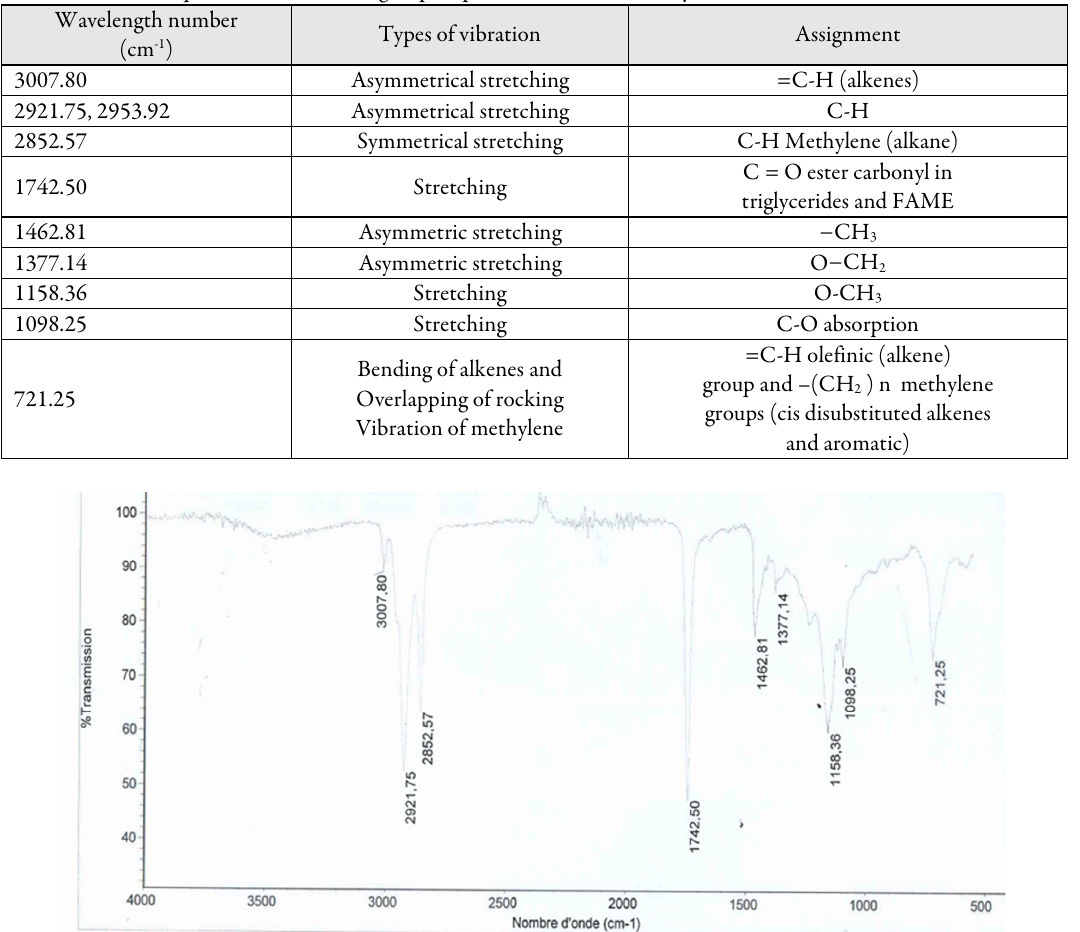
Table 3 related to the C-H aliphatic fatty acid stretch. The strong density of about 1742.50 cm -1 shows the C- O stretching of esters typical, and thus are common in fatty acid methyl esters spectral. The peak at 1462.81 cm -1 correspond to the asymmetric stretching of -CH present in the oil spectrum, in addition to other groups 3 shown in the Table 3 and Figure 1. Table 3Table 3Table 3Table 3. Frequencies of functional groups expected from OFI oil analysis